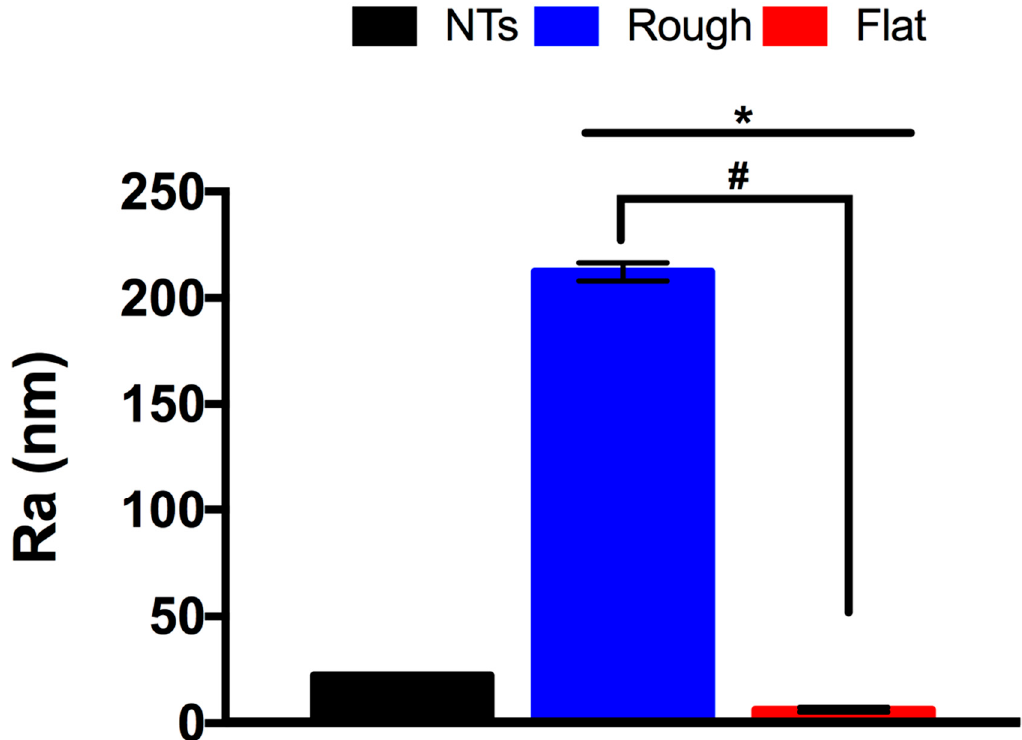
Figure 2. Analytical surface roughness comparison of the experimental substrates. * indicates significant differences between NTs and all the materials. # shows imperative changes among the rough and flat specimens.